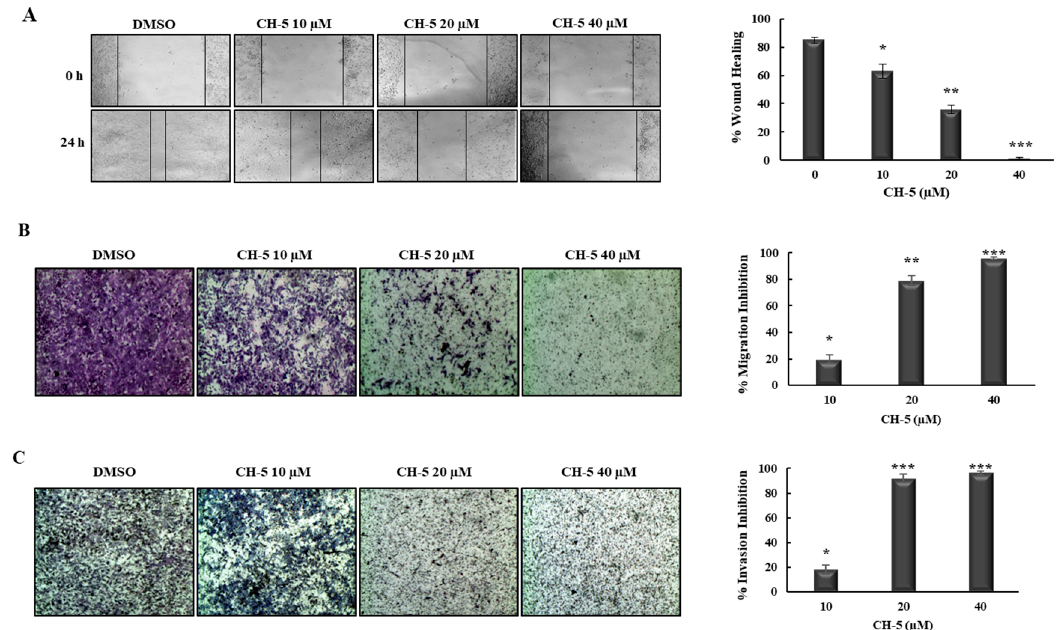
Figure 2. CH-5 inhibited cell migration and invasion in HGC-27 cells. ( A ) The effect of CH-5 on HGC-27 cell migration was evaluated by a wound healing assay. HGC-27 cells were scratched and treated with 0, 10, 20, and 40 µM of CH-5 for 0 and 24 h. The migration was observed under a phase-contrast microscope at a magnification of 40×. Migration inhibition (%) after treatment with CH-5 was calculated, and quantitative results are illustrated in the right panel; ( B ) The inhibitory effect of CH-5 on HGC-27 cell migration was detected by a Transwell assay. Cells in serum-free medium were plated onto the upper chamber of the Transwell. Complete medium (10% serum) containing CH-5 at the indicated doses was added to the lower chamber. After 24 h, cells on the bottom side of the Transwell membrane were stained and observed by manual counting and measuring absorbance at 490 nm. Migration Inhibition (%) was calculated and quantitative results are illustrated in the right panel; ( C ) For the invasion assay, the Transwell membrane was pre-coated with Matrigel, following which the cells were plated and treated as described above. Invasion Inhibition (%) was calculated and quantitative results are illustrated in the right panel. In all experiments, the data represent the mean ± SD of three experiments. * p ≤ 0.05, ** p ≤ 0.01, and *** p ≤ 0.001 vs. DMSO group.